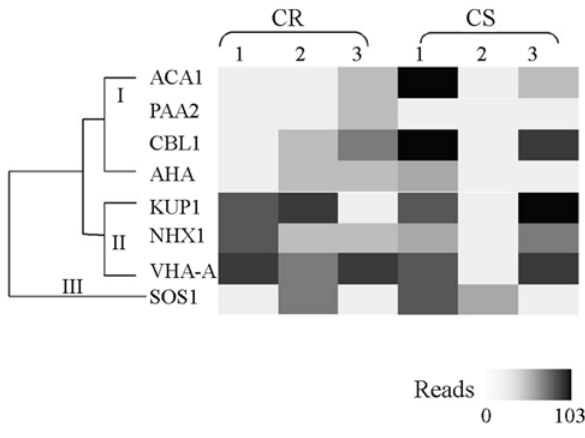
Figure 1 - Expression profile of ion transporter-like transcripts in fruit de- velopment libraries stage 1, 2 and 3 from Citrus sinensis (CS) and Citrus reticulata (CR). Data represents the normalized relative number of reads